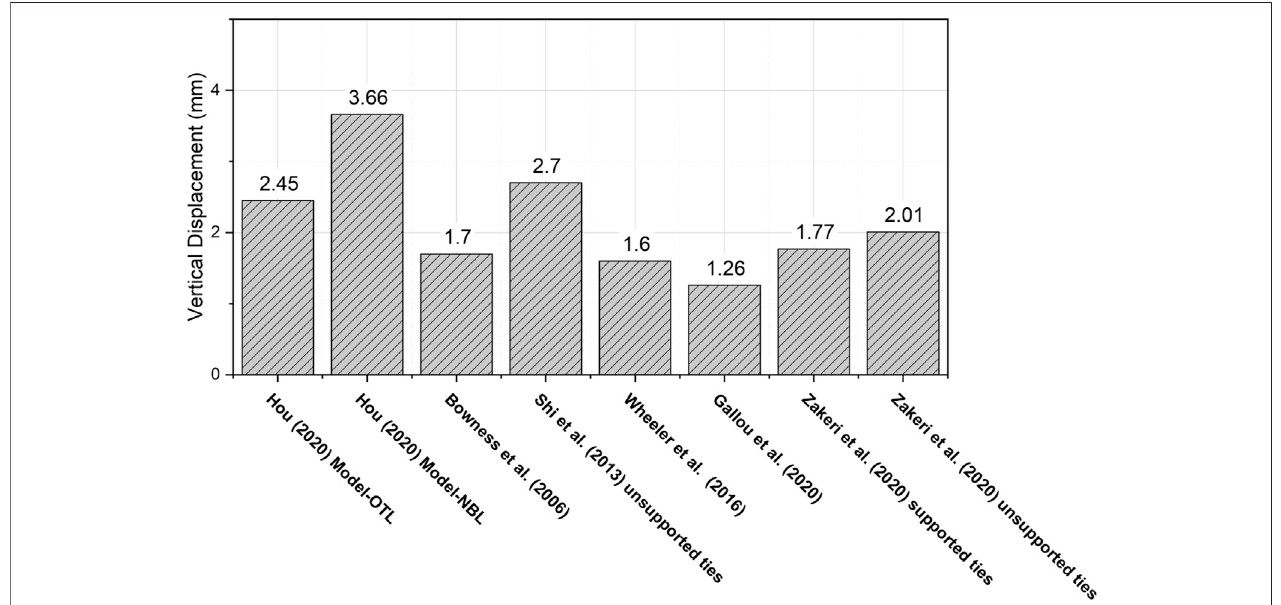
FIGURE 8 | Comparison of rail vertical displacements with freight trains passage predicted by model and obtained from other studies.